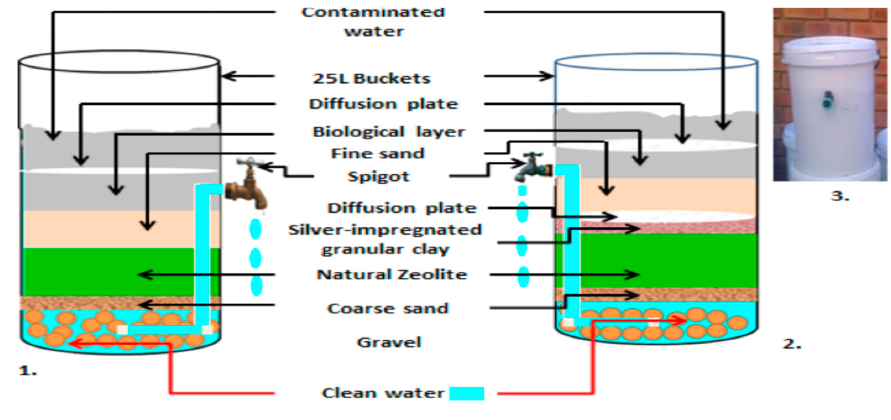
Figure 1. Schematic representation of biosand filters: 1. BSF-Z; and 2. modified BSF with zeolite and silver-impregnated granular clay; 3. BSZ-SICG filter (7 mm gravel; 0.95 mm coarse sand; 3 mm natural zeolite; silver-impregnated granular clay; 0.15 mm fine sand).